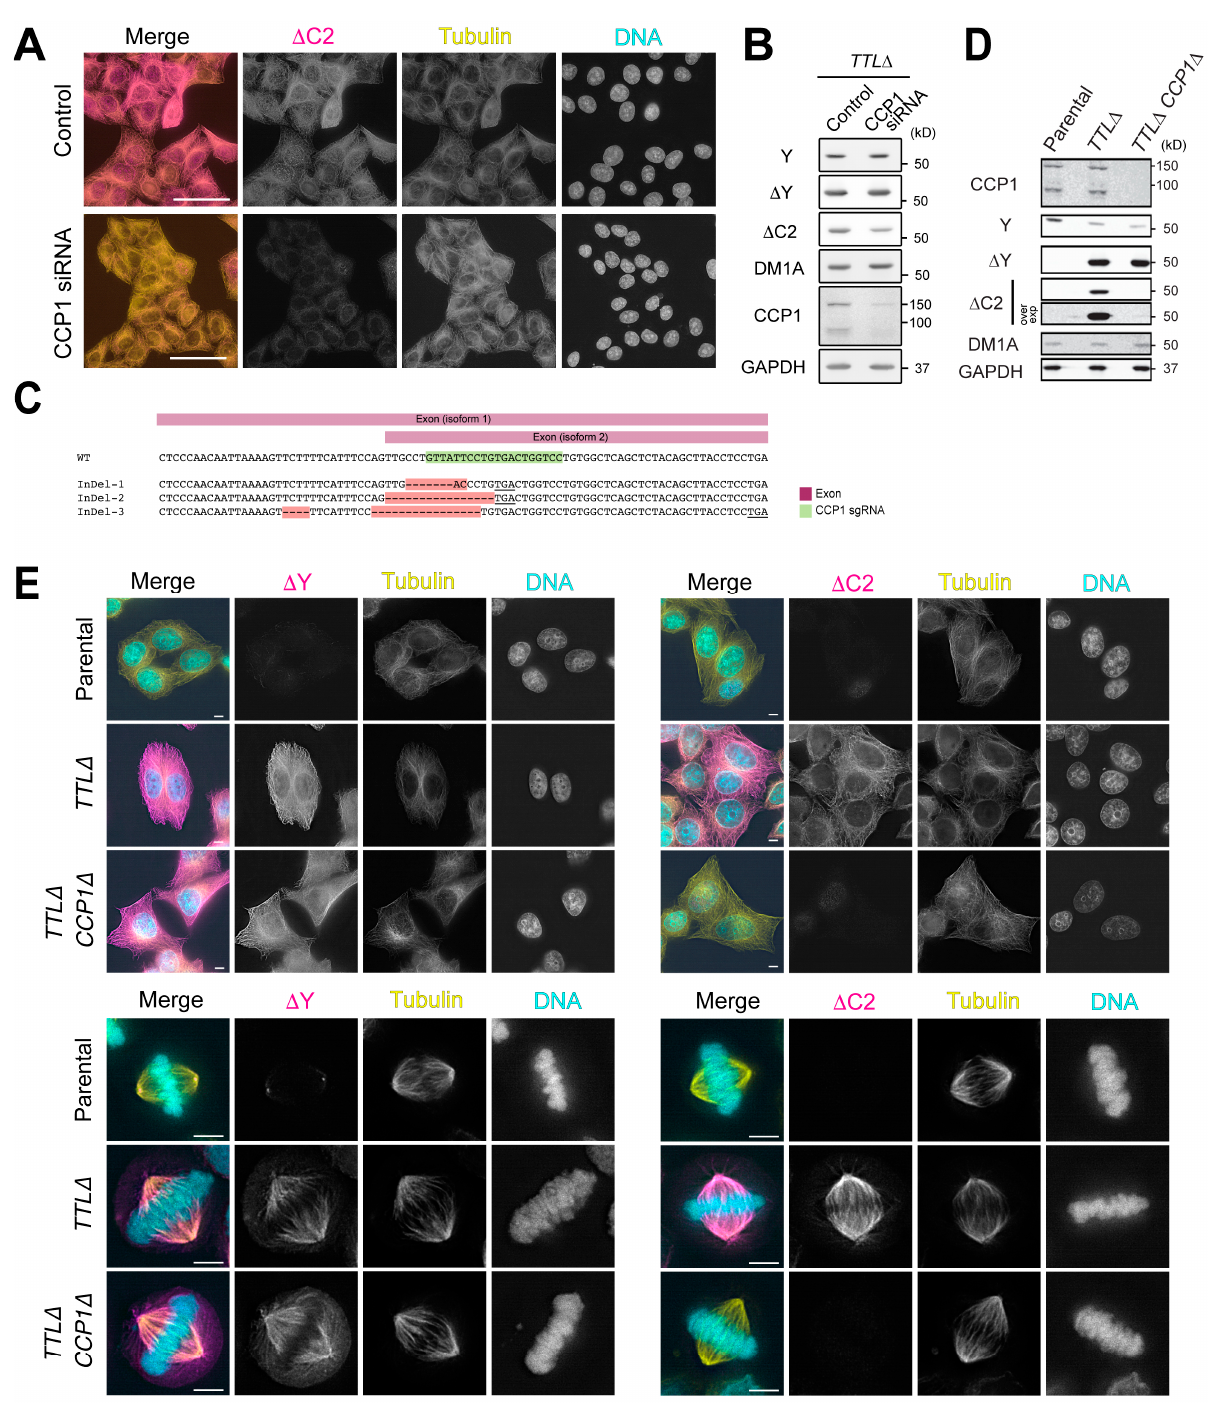
Figure 3. CCP1 is the sole peptidase that generates ∆ C2- α -tubulin in TTL ∆ cells. ( A , B ) siRNA-mediated knock down of CCP1 in TTL ∆ cells, followed by detection of ∆ C2- α -tubulin with immunofluorescence ( A ) and immunoblotting ( B ). In merged images in ( A ), ∆ C2- α -tubulin is shown in magenta, total α -tubulin (DM1A staining) in yellow, and DNA (DAPI staining) in cyan. Scale bars in ( A ), 50 µm. ( C ) Detection of CRISPR/Cas9-induced INDELs in the CCP1 locus in TTL ∆ CCP1 ∆ line. Expected premature stop codons were indicated by underlines. ( D , E ) Detection of ∆ C2- α -tubulin in the TTL ∆ CCP1 ∆ line by immunoblotting in cell lysates ( D ) and immunofluorescence ( E ). In merged images in ( E ), ∆ Y- or ∆ C2- α -tubulin is shown in magenta, total α -tubulin (DM1A staining) in yellow, and DNA (DAPI staining) in cyan. Scale bars in ( E ), 5 µm.